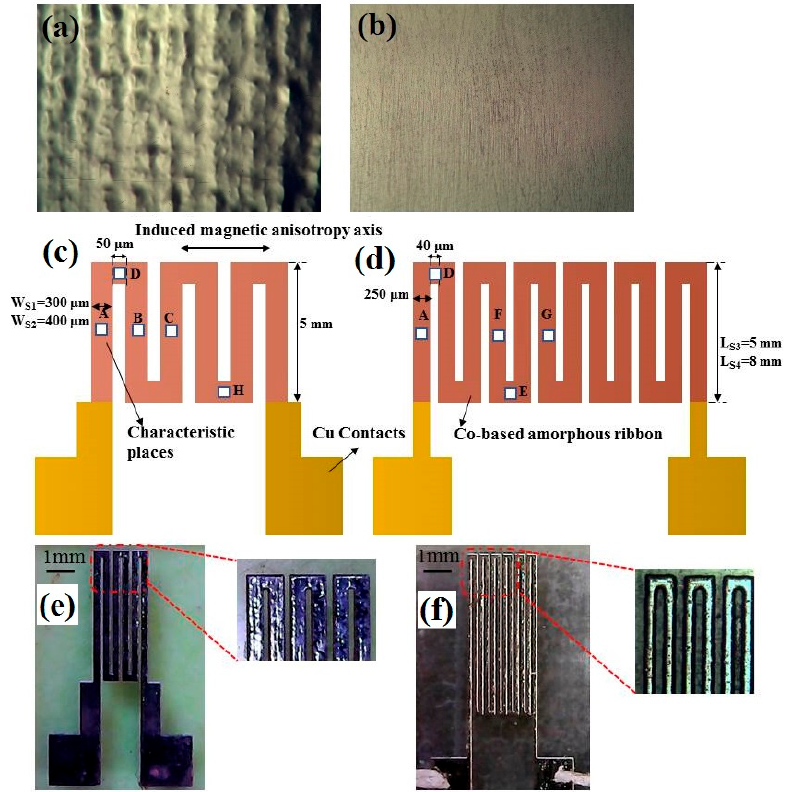
Figure 1. Surface micrograph of the Co 75 Fe 10 Ni 2 Si 8 B 5 ribbon after chemical etching ( a ). Surface micrograph of the chemical etched Co 75 Fe 10 Ni 2 Si 8 B 5 ribbon after polishing ( b ). The description